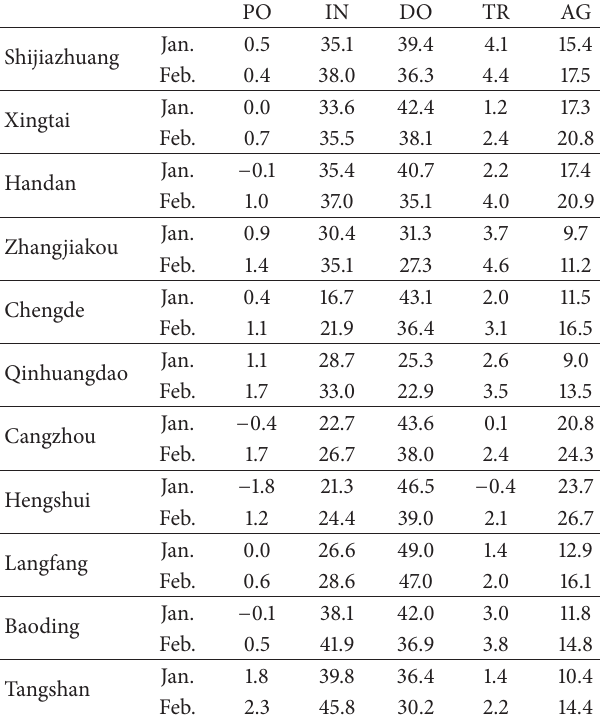
Table 3: The sectoral contributions to the PM 2.5 concentrations in 11 cities of